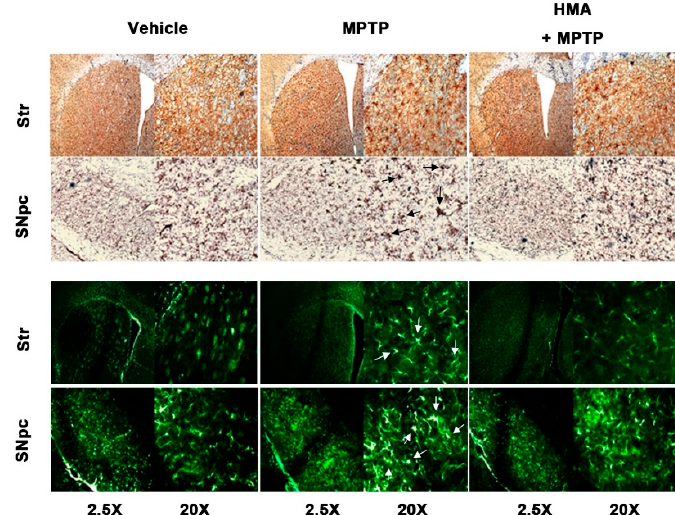
Figure 6. Inhibitory e ff ect of HMA on MPTP-induced activated microglial and glial markers expression in the striatum (STR) and substantia nigra pars compacta (SNpc). Representative microphotographs of macrophage Ag complex-1 (MAC-1, upper panel) and glial fibrillary acidic protein (GFAP, lower panel) by immunohistochemistry-immunofluorescence assay (IHC-IF). HMA (30 mg / kg) was administered for 14 days and, MPTP was administered 20 mg / kg (four injections per day at 2 h intervals) on the last day of HMA treatment. Mice were anesthetized for the IHC-IF study 1 day after the last MPTP treatment. The activation sites in MPTP-induced mouse brain tissues are indicated with arrows.